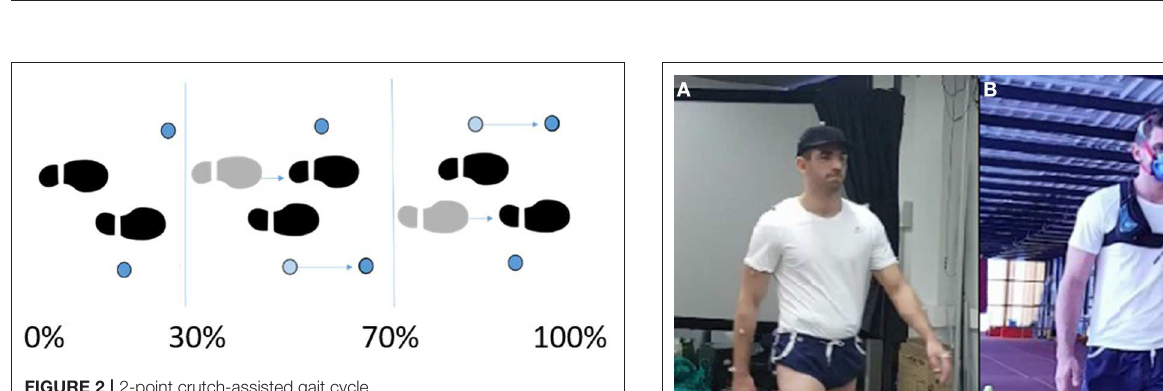
FIGURE 2 | 2-point crutch-assisted gait cycle.